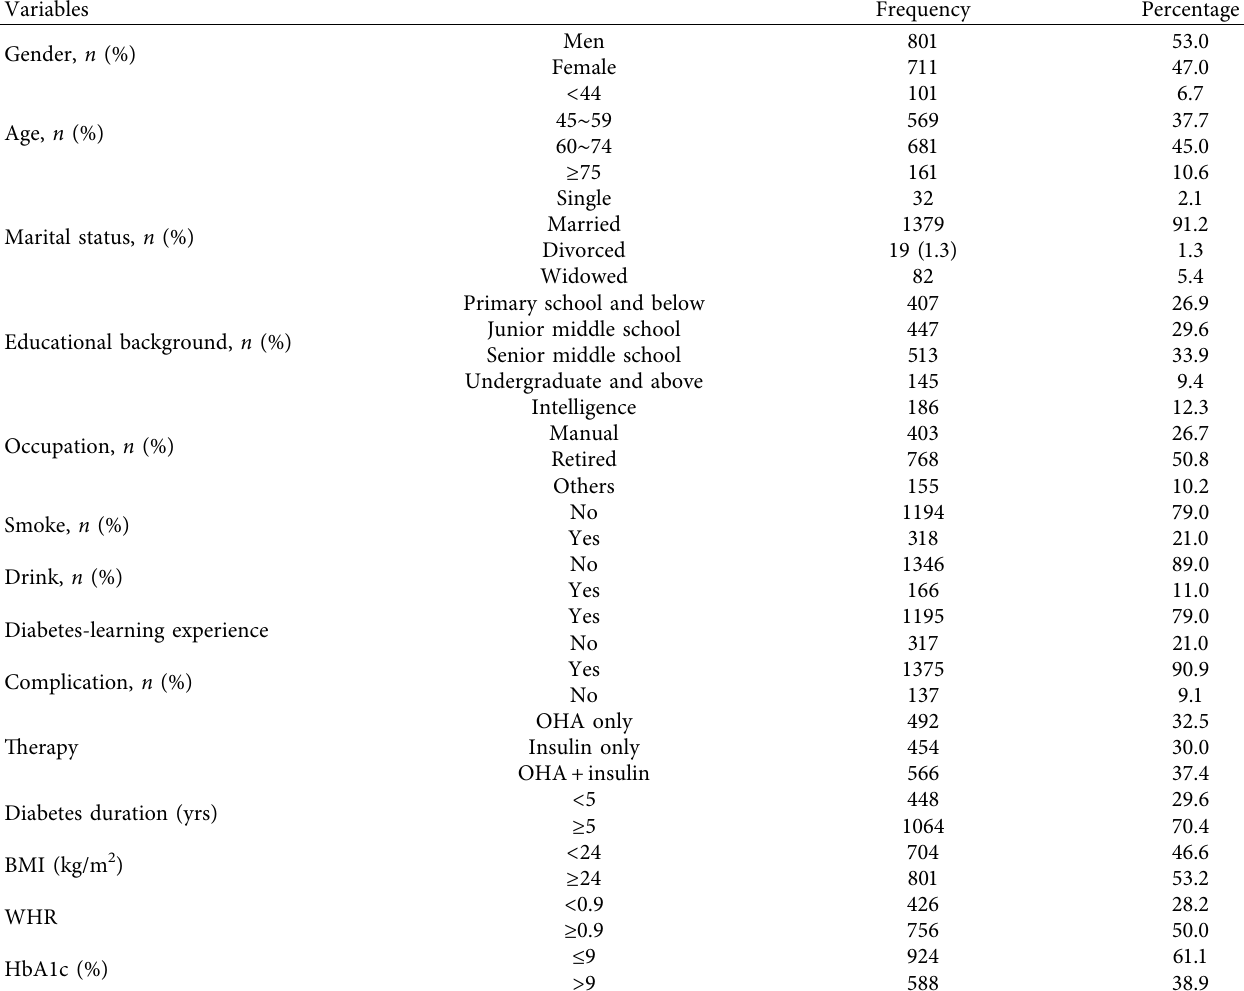
Table 1: Demographic and clinical characteristics of patients with type 2 diabetes.